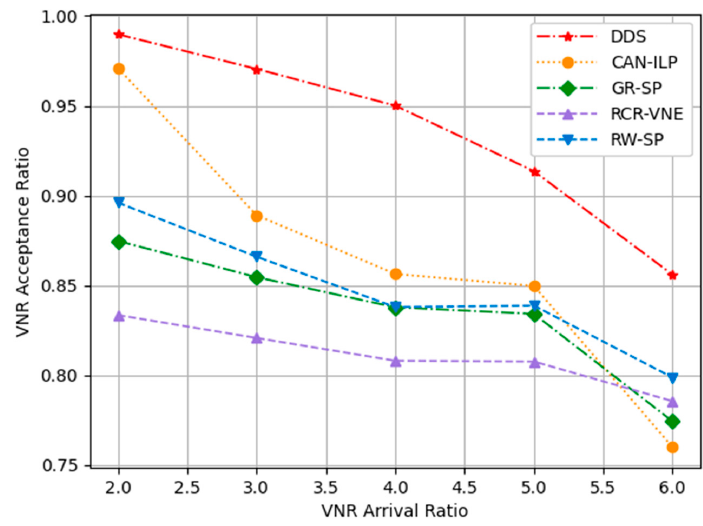
Figure 3. VNR acceptance ratio under various VNR arrival ratios.